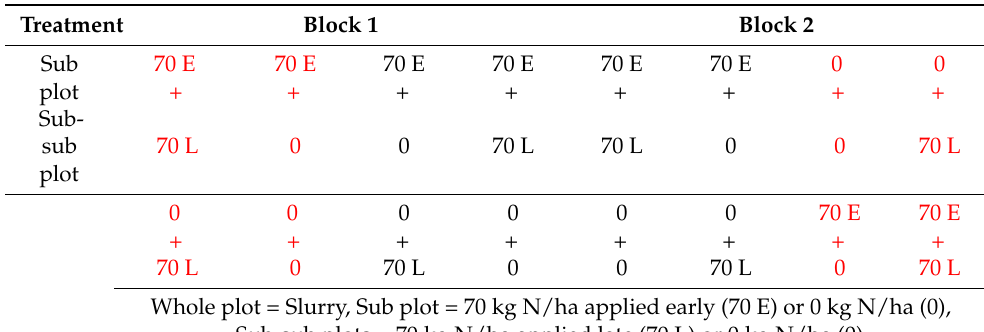
Table 4. Split-split plot design implemented in 2017/18. Treatment Block